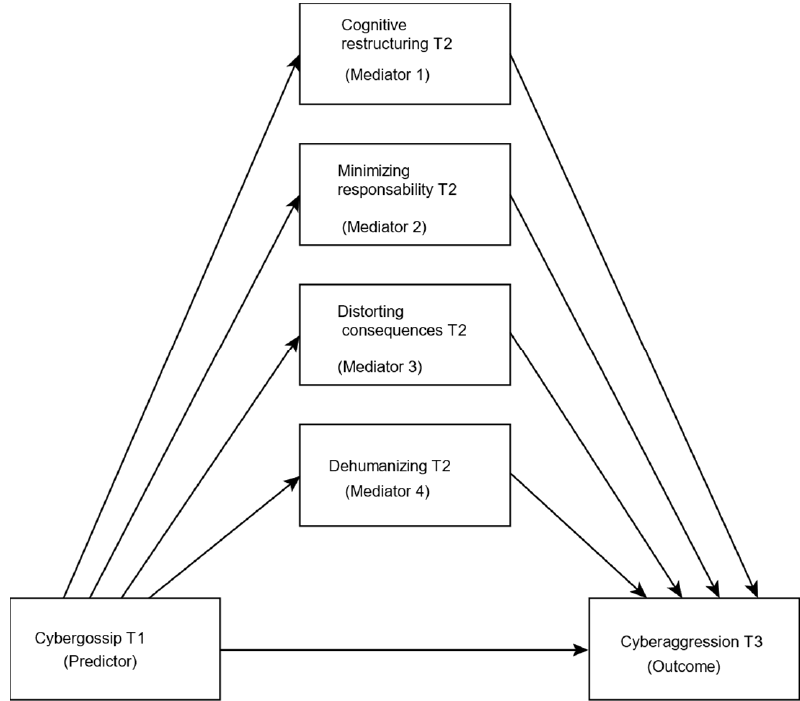
Figure 1. Proposed mediation model.